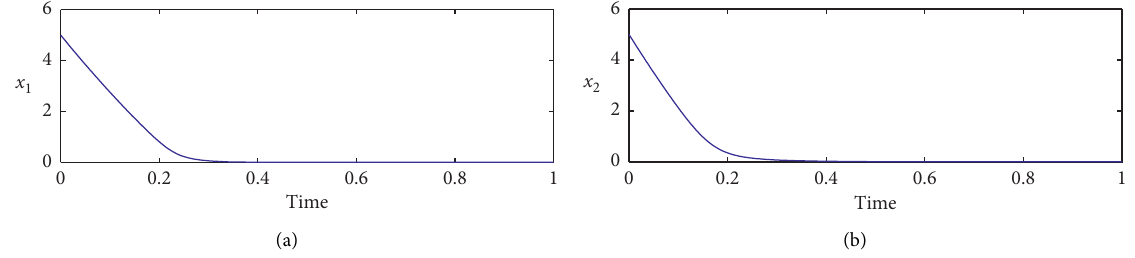
Figure 3: Transient behavior of (a) x